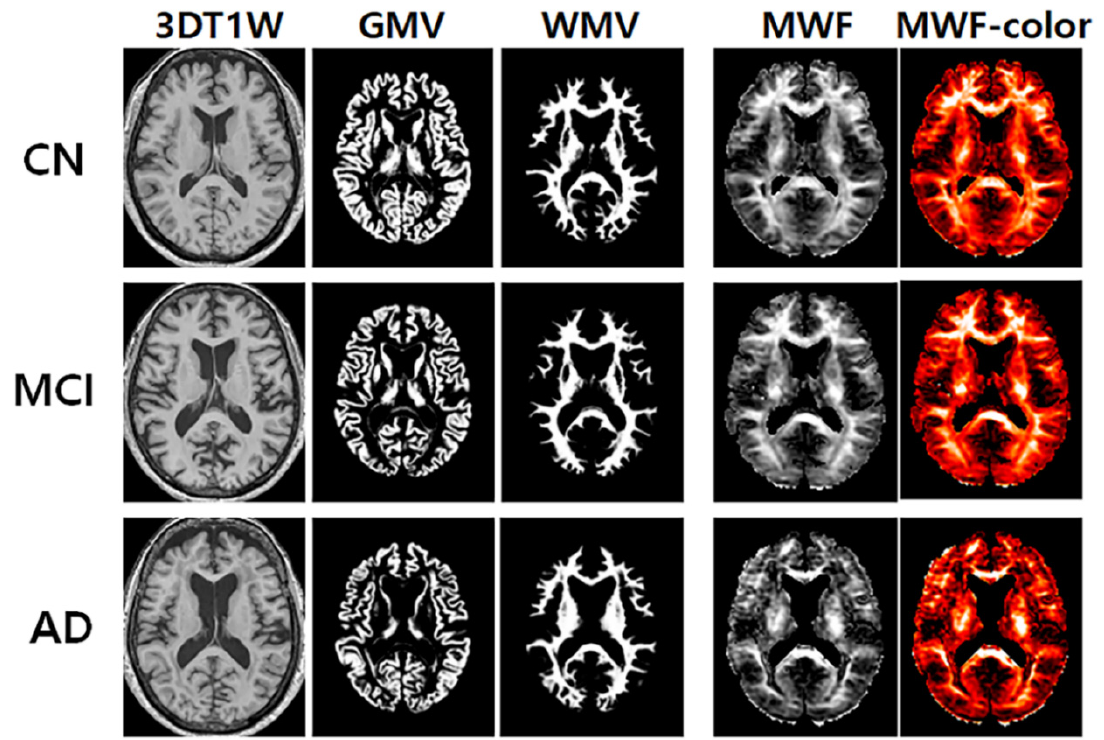
Figure 1. Representative maps of the three-dimensional (3D) T1-weighted (T1W), gray matter volume (GMV), white matter volume (WMV), and apparent myelin water fraction (MWF) with and without color